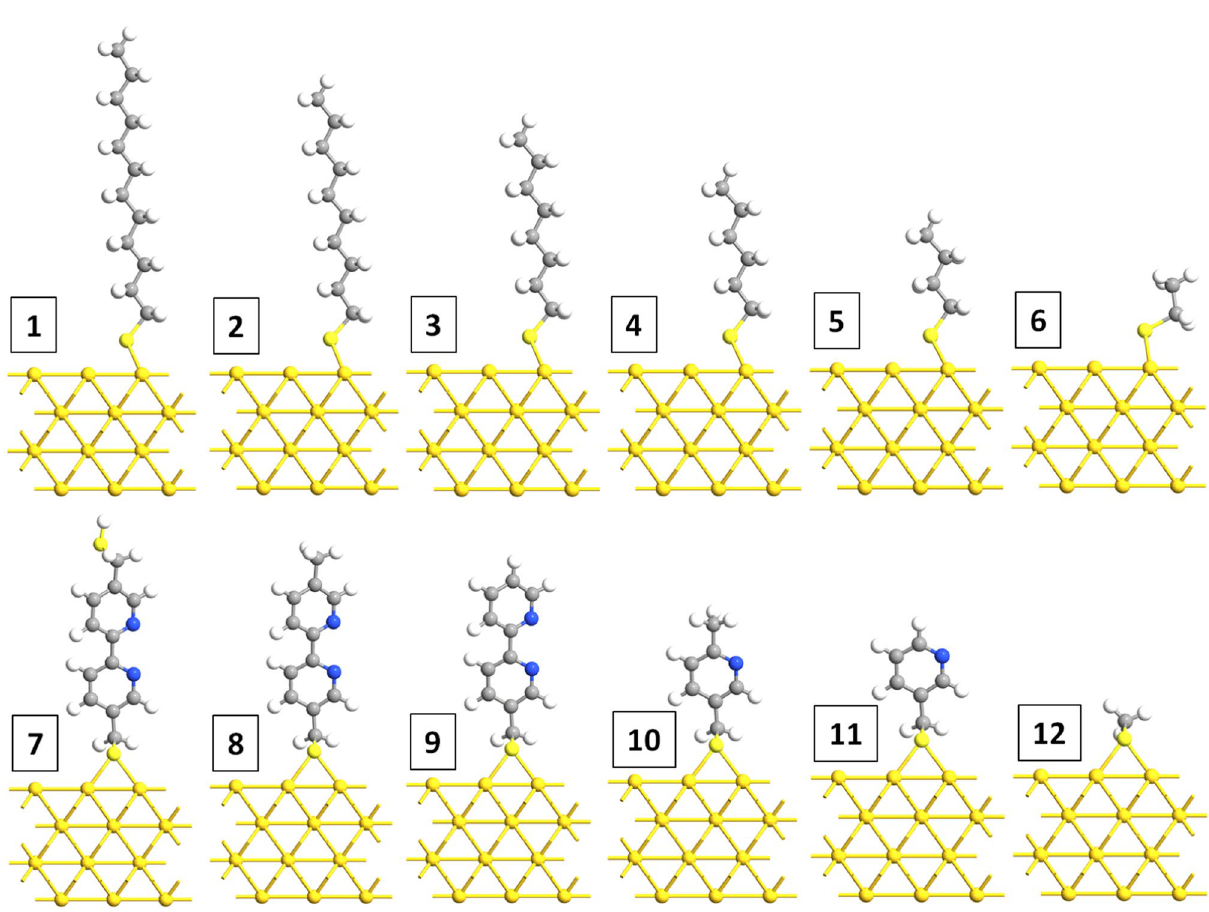
Figure 5. Model systems: optimized structures of C12 (panel 1) and its derivatives (panels 2–6) and BPD (panel 7) and its derivatives (panels UPS signal to the strong contribution of Au-substrate, which is initially screened by the molecular layer. This also explains the fact that the position of the UPS maxima, at these low energies, does not change with etching. The reduction in the “screening” effect is more pronounced in the C12 system, indicating that C12 molecules get more damaged during the ion bombardment. The situation changes considerably at higher (> 7 eV) binding energies, where, for both samples, the amplitude of the UPS maxima decreases, while their position shift to higher energies, with increasing the etching time (arrows 4 in Fig. 4). With further increase of the binding energy, a UPS maximum is obtained around 13.5 eV for both samples. To understand the features on the UPS spectra during the etching process, we have conducted DFT simu- lations for C12 and BPD molecules and their possible derivatives. Figure 5 shows our model systems for C12 (panels 1–6) and BPD (panels 7–12) derivatives. The selected structures were optimized using periodic bound- ary conditions along the lateral directions, and large vacuum regions perpendicular to the gold (111) substrate. The coordinates of the atoms in the last layer of the gold substrate were kept fixed during the optimizations to represent the bulk structure. All molecules are attached to the substrate through S–Au covalent bonding. For both types of molecules S atoms are bound to 2 neighboring gold atoms (i.e., bridge geometry bonding). We attempt to use the simulated models to explain the shift observed in the UPS spectra of the considered systems indicated by dashed arrows 4 in Fig. 4. Figures 6a,b show the calculated density of states (DOS) for 3 BPD-based structures (thick curves in Fig. 6a and panels 1–3) and 3 C12-based structures (thick curves in Fig. 6b and panels 4–6). As comparison, we also present the experimentally obtained UPS signals (thin curves in Fig. 6). Dashed black line in Fig. 6a highlights the blue shift of the experimental UPS spectra at different etching levels. The calculated DOS (solid thick lines in Fig. 6a) shows a similar pattern as in the experiment. For example, the calculated DOS of the system also shows a blue shift in this range of the energy. To see the contribution of the electronic states to the DOS of the system and to understand the nature of the peaks on the UPS spectra, we have calculated electronic eigenstates for different energy values. Panels 1–3 in Fig. 6 show the electron density of the states corresponding to the peaks on the DOS curves indicated by symbols 1–3 in Fig. 6a. As expected, only the electron density of the adsorbed molecules contributes to the DOS of the system for the considered energy values. Therefore, the peaks shift to higher energies because the binding energy of smaller fragments becomes higher. At low energies, the gold atoms strongly contribute to the DOS of the system. The positions